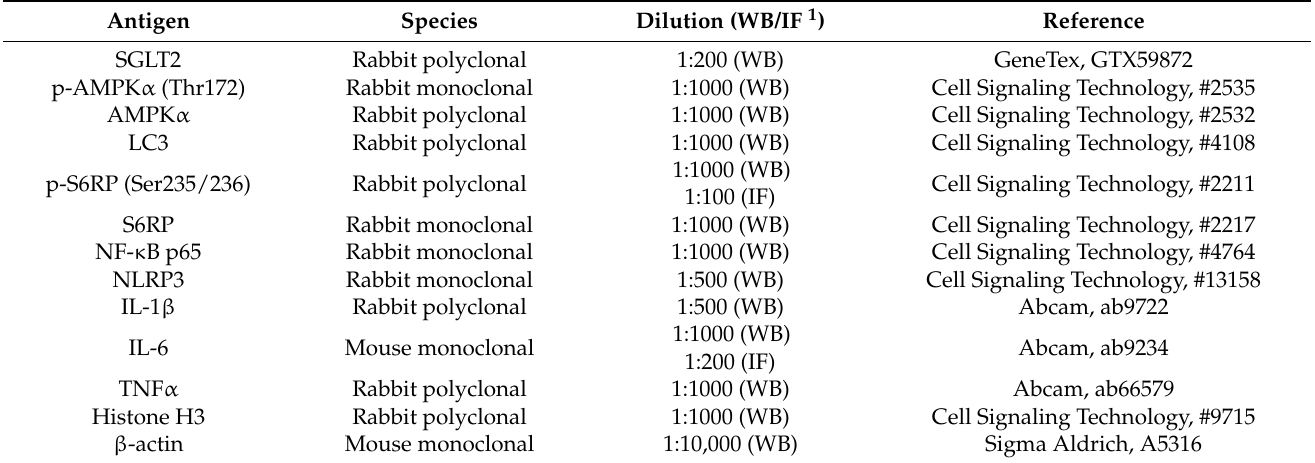
Table 2. Antibodies used for western blotting and